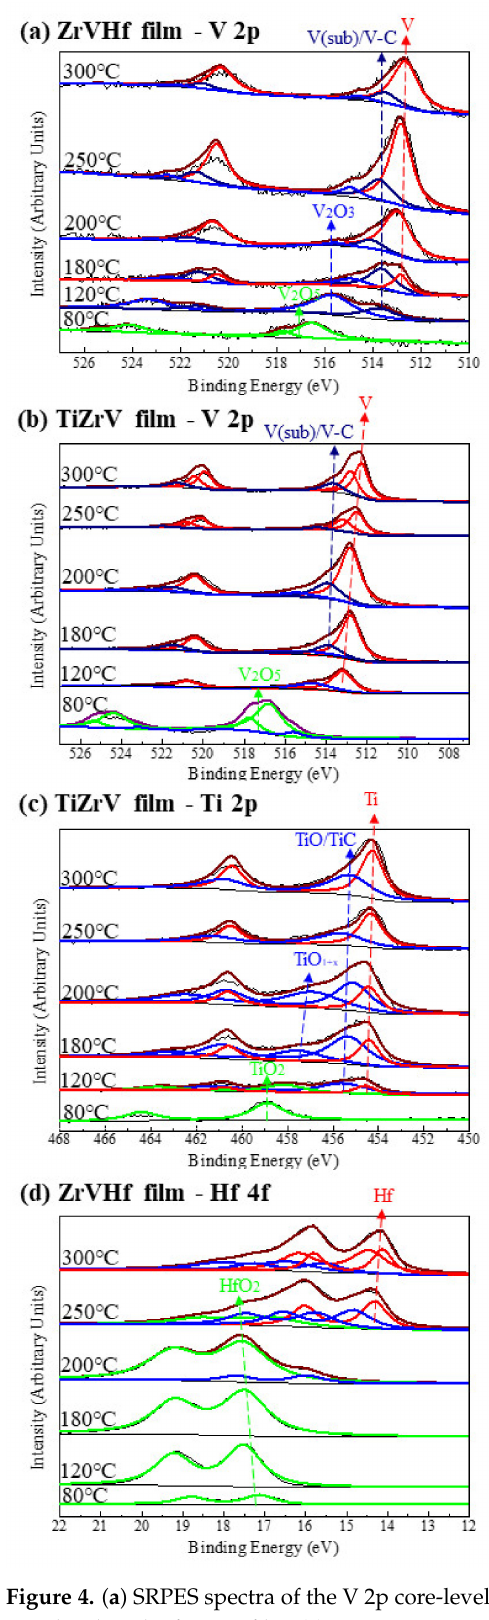
Figure 4. ( a ) SRPES spectra of the V 2p core-level peak of ZrVHf film; ( b ) SRPES spectra of the V 2p core-level peak of TiZrV film; ( c ) SRPES spectra of the Ti 2p core-level peak of TiZrV film; ( d ) SRPES spectra of the Hf 4f core-level peak of ZrVHf film. All were recorded after heating the films at various temperatures indicated in the